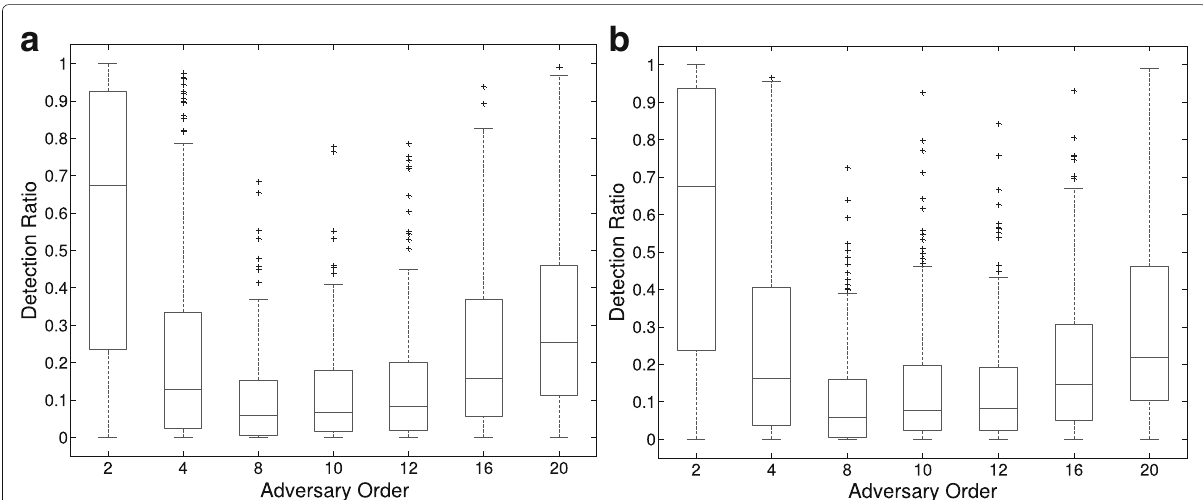
Fig. 10 Numeric simulation results using the single- and multi-watermark detection schemes with the same performance loss, different adversary system order, and a window size equal to 200. a Detection ratio regarding single-watermark for systems of order ten. b Detection ratio regarding multi-watermark for systems of order ten. a Detection ratio function with respect to the single-watermark against a parametric cyber-physical adversary using different adversary system order. b Detection ratio function with respect to the multi-watermark against a parametric cyber-physical adversary using different adversary system